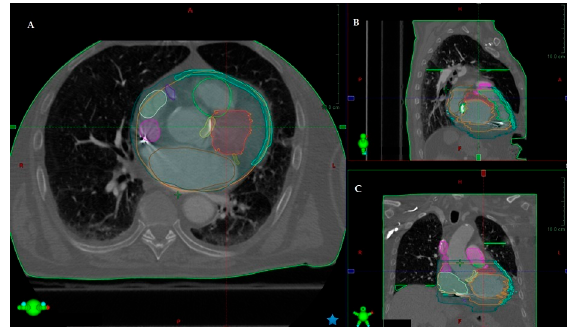
Figure 1. Treatment plan simulation. Contouring of the Planning Target Volume with respect to the intracardiac structures and the Organs at Risk is obtained through integrated “free-breathing” simulation-CT imaging. The Planning Target Volume in the axial ( A ), sagittal ( B ), and coronal ( C ) view, as delineated by the red contour line, is depicted.